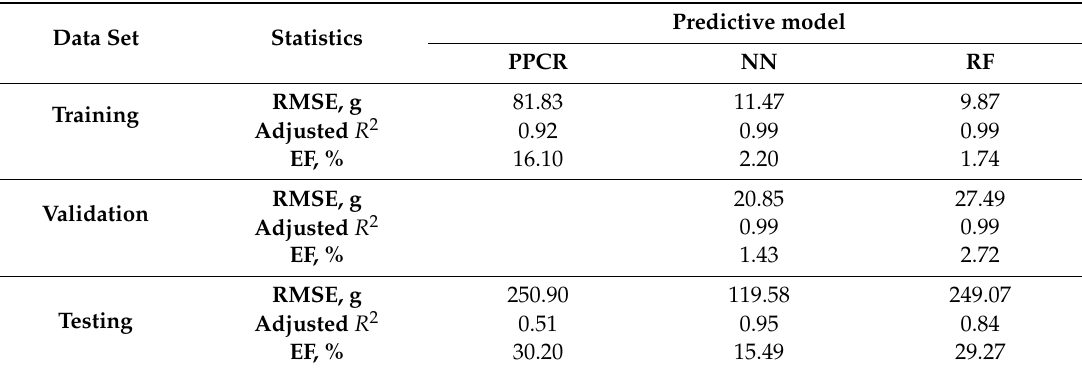
Table 4. Performance of the predictive models shown in Figures